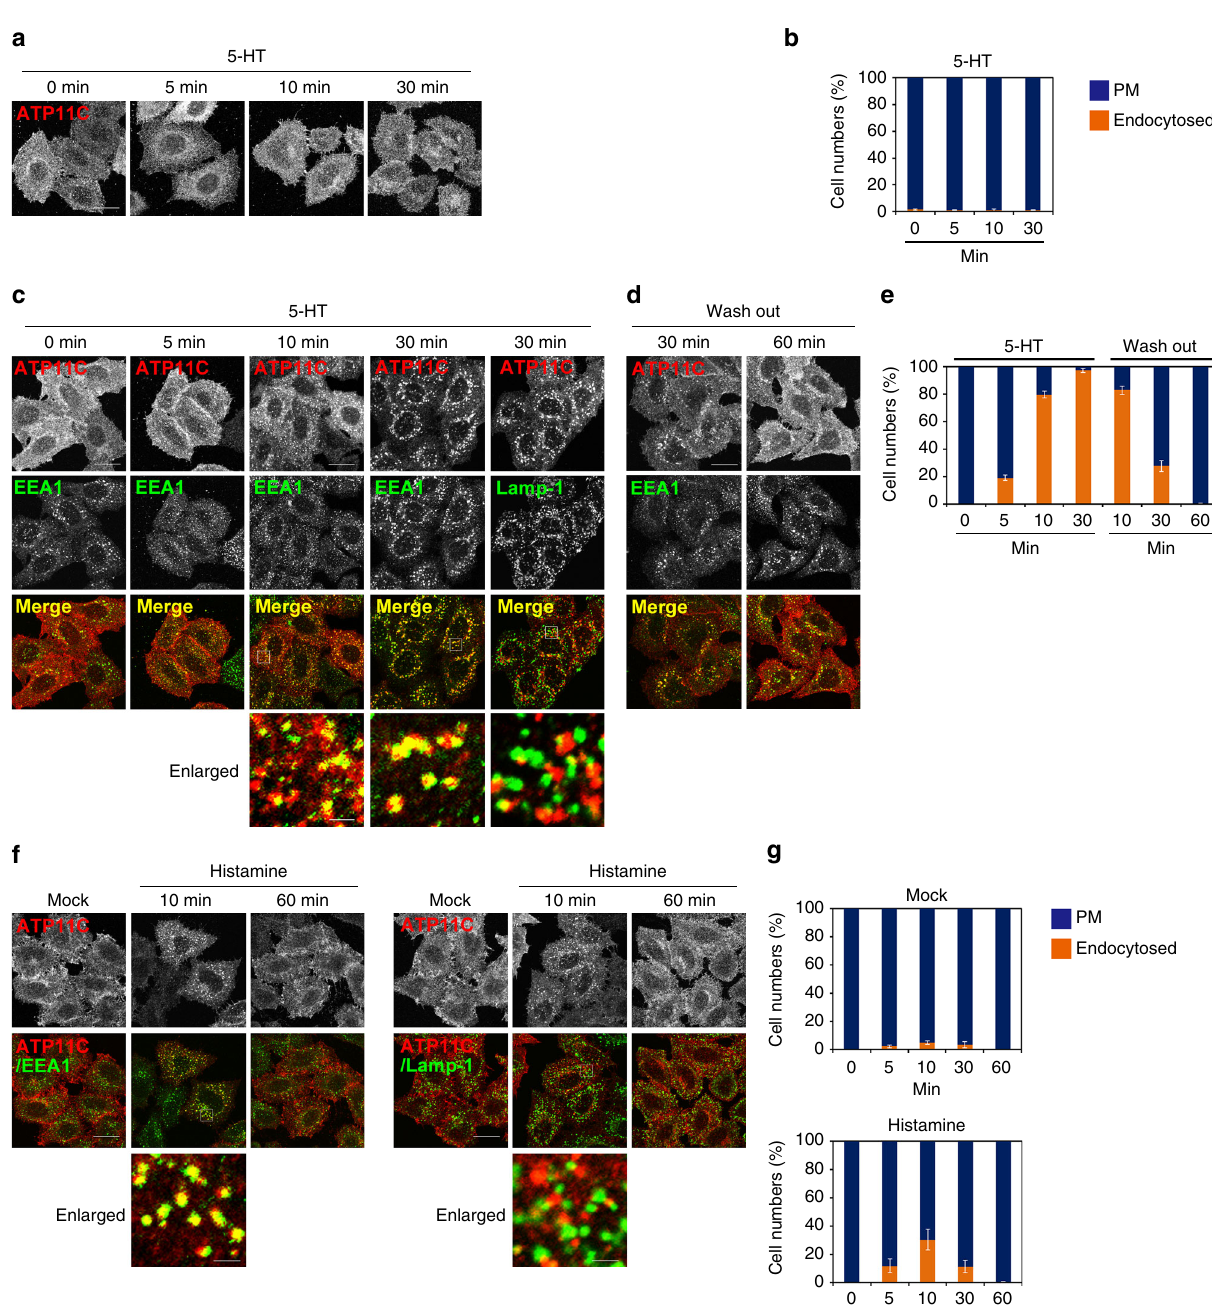
Fig. 10 ATP11C is endocytosed by treatment with serotonin or histamine. a – e HeLa cells stably expressing C-terminally HA-tagged ATP11C alone ( a , b ) or ATP11C-HA and untagged 5-HT2A-R ( c – e ) were serum starved for 3 h and treated with 500 nM 5-HT for indicated times c . See Supplementary Movie 2. After 30 min treatment, cells were washed with 5-HT-free medium and incubated in the medium for indicated times ( d ). f , g HeLa cells stably expressing C-terminally HA-tagged ATP11C were treated with vehicle alone (Mock) or 5 μ M of histamine for indicated times. The cells were fi xed and doubly stained for HA, and EEA1 or Lamp-1 followed by incubation with Cy3-conjugated anti-rat and Alexa Fluor 488-conjugated anti-mouse secondary antibodies ( f ). Images were obtained by confocal microscopy. Scale bars, 20 μ m. Insets are enlarged (bars, 2 μ m). b , e , g Cells in which ATP11C localized to the plasma membrane (PM), or to the plasma membrane and endosomes (endocytosed) were counted; counts were normalized against the total number of counted cells. In each sample, 370 – 1273 cells were counted. Graphs display averages ± SD from four ( b , e ) or three ( g ) independent